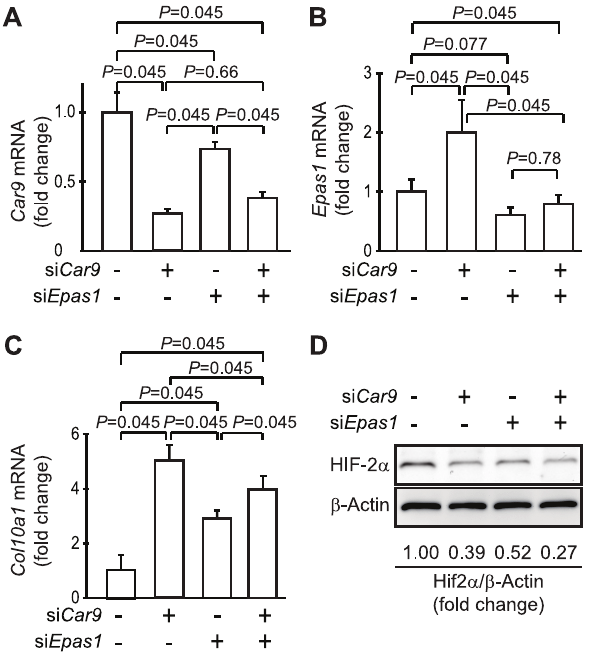
Figure 7. Independent regulation of expressions of Epas1 and Col10a1 by CA IX. Car9 siRNA (si Car9 ) and Epas1 siRNA (si Epas1 ) were simultaneously introduced into primary chondrocytes. The expression levels of mRNAs for Car9 ( A ), Epas1 ( B ), and Col10a1 ( C ) were quantitatively analyzed by real-time RT-PCR. The expression level of each gene was normalized to that of Gapdh and is shown as the relative value to that obtained with cells introduced with only control siRNA (leftmost column in each graph). Data are expressed as the mean 6 SD of 5 experiments. P -values obtained by Steel-Dwass test were indicated. D. The expression of HIF-2 a protein in chondrocytes was examined by western blot analysis at 48 hours after introduction of siRNAs for Car9 (si Car9 ) and/or Epas1 (si Epas1 ). The expression level of HIF-2 a in each cellular extract was normalized by that of b -actin. The values under the photographs show the fold change in HIF-2 a / b -actin ratio by the introduction of siRNAs for Car9 and Epas1 relative to that obtained by the introduction of control